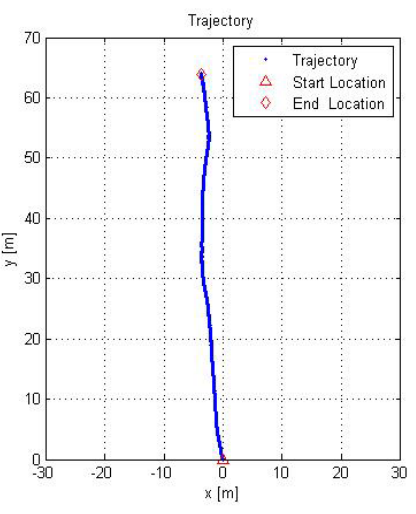
Figure 3. Straight line path of 50 meters